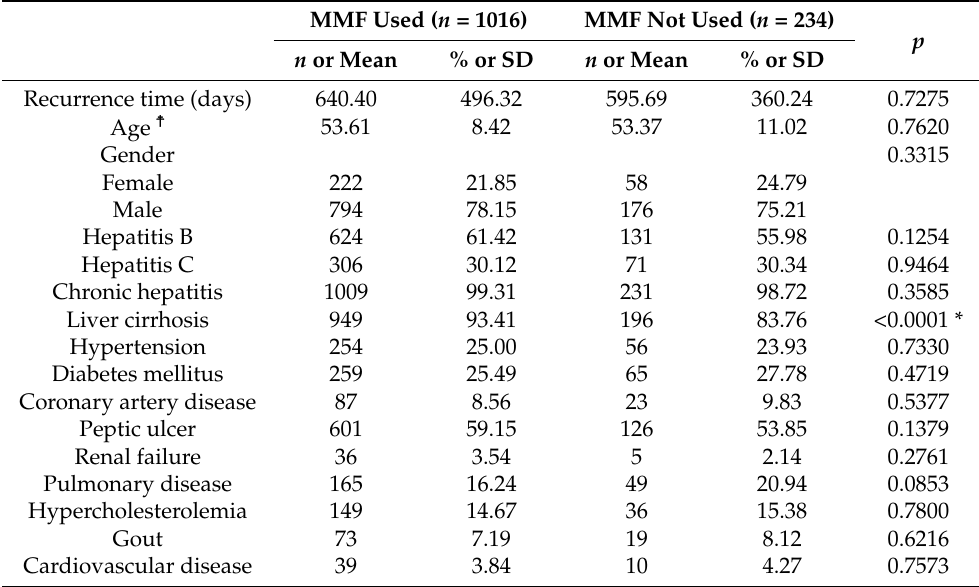
Table 3. Demographic Data and Clinical Characteristics of Liver Transplant Recipients in the Study Table 1. Demographic Data and Clinical Characteristics of the Liver Transplant Recipients in the Study Case (HCC Recurrence) Case (MMF Use) and Control (MMF Nonuse) Groups. and Control (Non-HCC Recurrence) Groups.